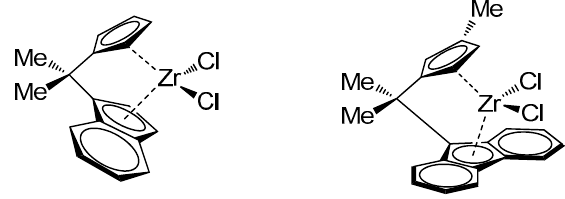
Figure 1. Ansa —zirconocene based precursors Figure 1. Ansa— zirconocene based precursors studied.